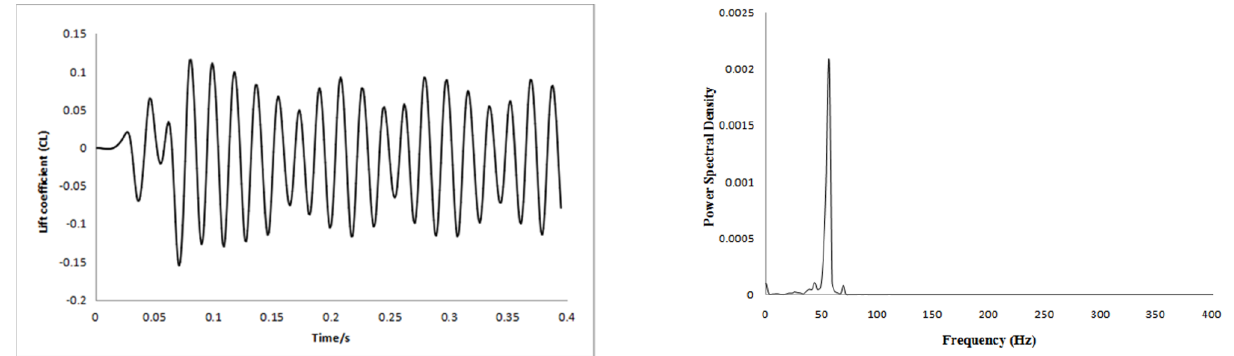
Figure 8. The lift coefficient time history curve and power spectrum curve of the vibration area under the 80% operation mode.